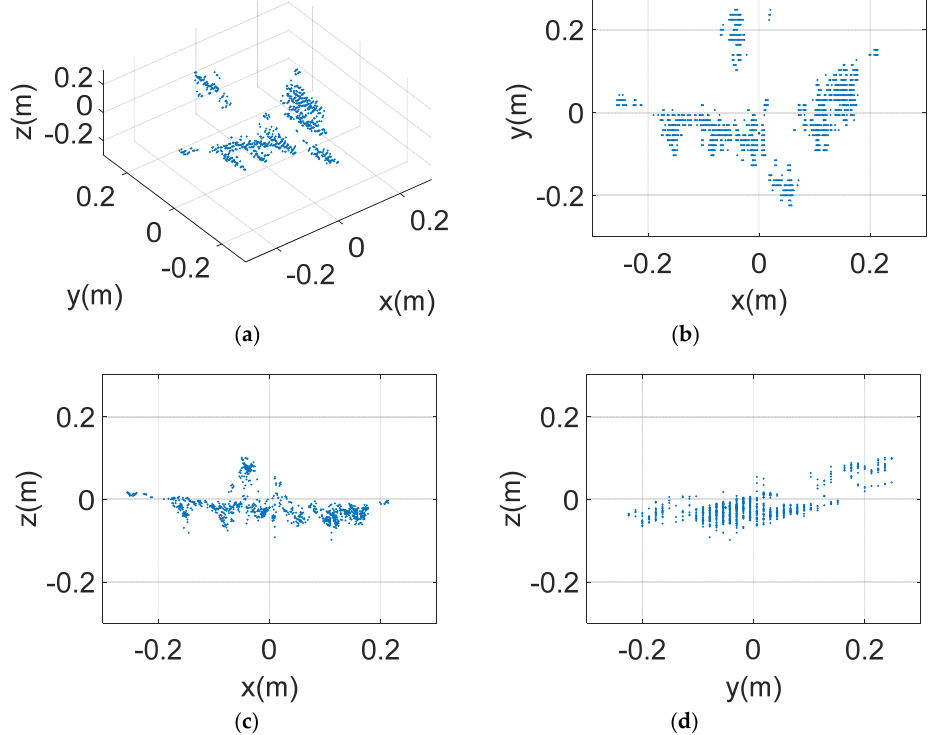
Figure 14. InISAR imaging results of the airplane model. ( a ) 3-D view; ( b ) xoy view projection; ( c ) xoz view projection; and ( d ) yoz view projection.